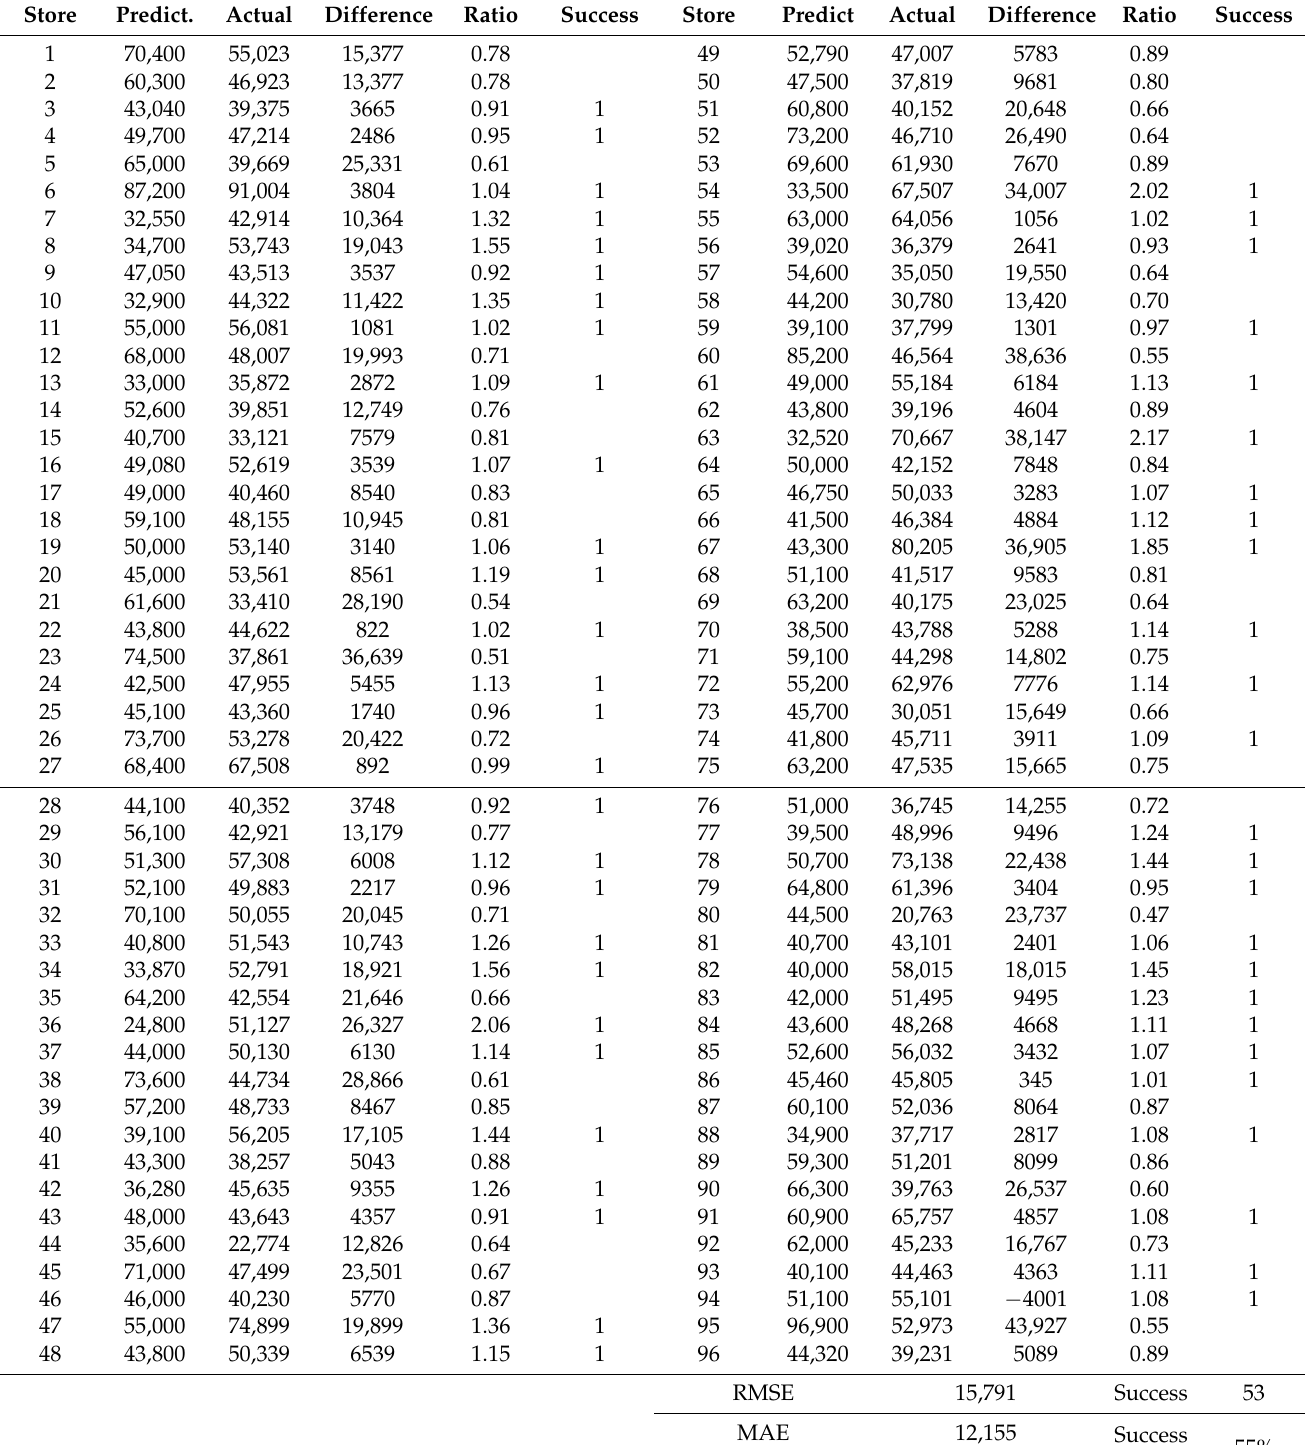
Table 5. Difference between predicted daily turnover and actual daily